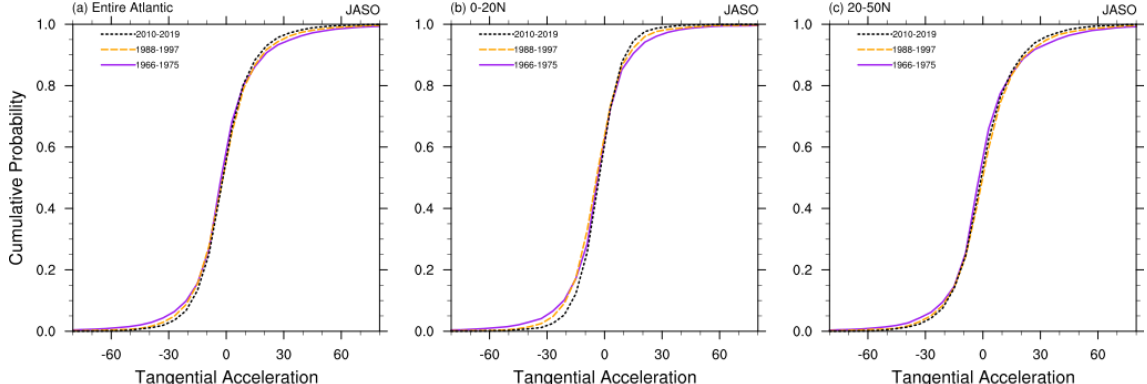
Figure 11. Cumulative distributions of tangential acceleration (kmh − 1 d − 1 ) for July–October 1966–2019 for (a) the entire Atlantic, (b) 0– 20 ◦ N, and (c) 20–50 ◦ N.